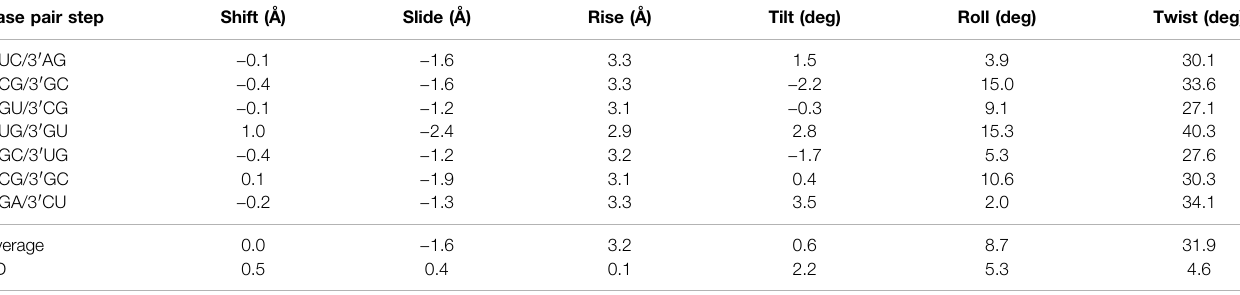
TABLE3| Simplebase-pairstepparametersofther(UCGUGCGA) 2 duplexbasedonconsecutiveC1 ′ – C1 ′ vectorscalculatedusingthe3DNAserver,v2.4.3-2019apr06(Lu and Olson, 2003; Li et al., 2019) Base pair step